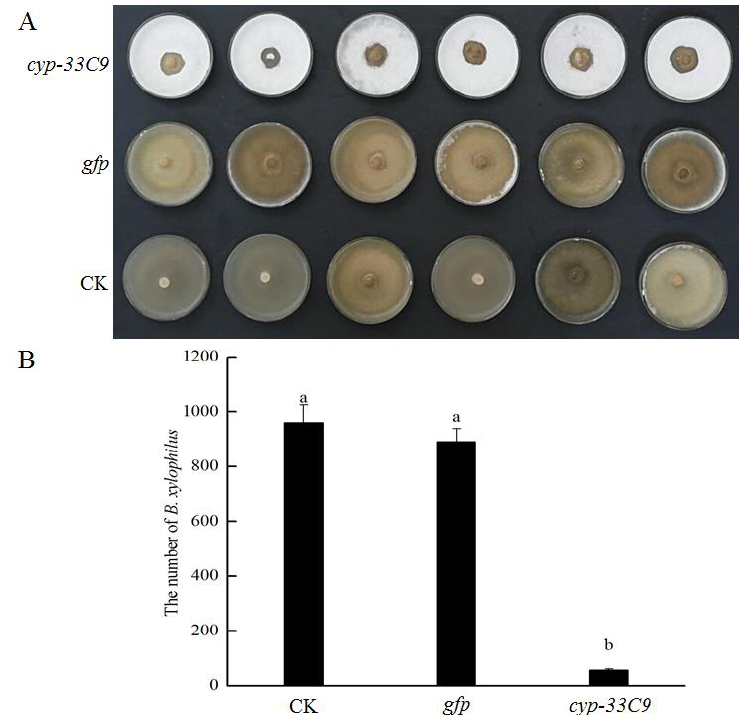
Figure 1. Effects of RNA interference (RNAi) on feeding and reproduction of Bursaphelenchus xylophilus . Botrytis cinerea cultures on potato dextrose agar (PDA) plates 5 d after inoculation with 200 s-stage juveniles (J2s) soaked in ddH 2 O (CK) or dsRNA ( gfp or cyp-33C9 ) ( A ); the numbers of B. xylophilus washed from PDA plates of B. cinerea inoculated with B. xylophilus J2s treated with ddH 2 O (CK) or dsRNA ( gfp or cyp-33C9 ). The error bars indicate standard deviations, and treatments with di ff erent letters indicate significant di ff erences ( p < 0.05) ( B ).